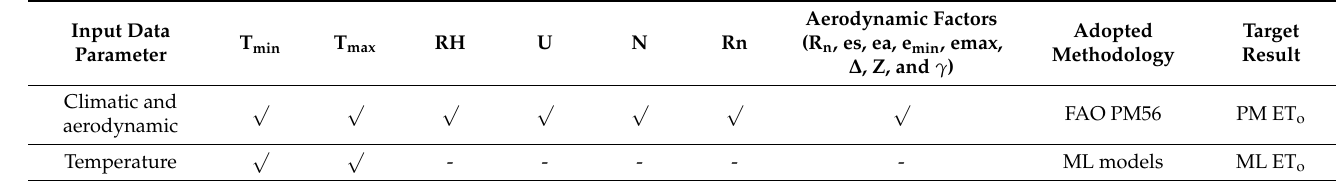
Table 9. Data requirements for FAO PM56 and ML models in ET o